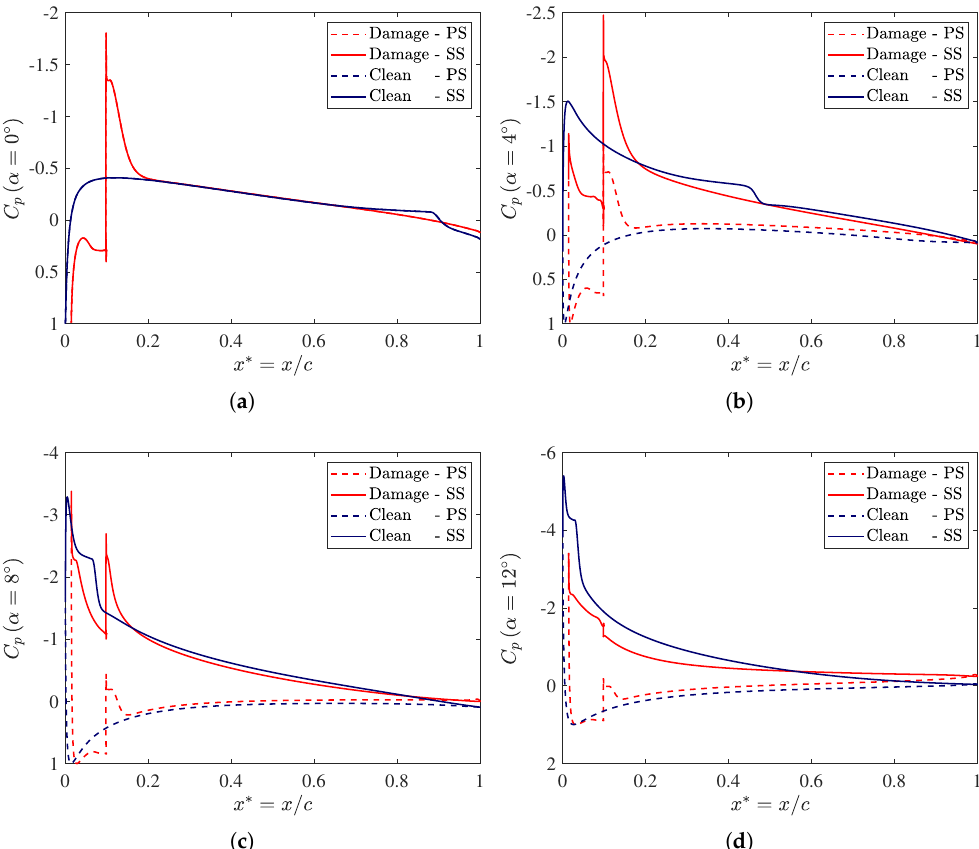
Figure 14. Pressure coefficients comparison between the clean airfoil and the damaged airfoil: the distribution on the Pressure Side (PS) is denoted with the dashed line, while the continuous line is used for the Suction Side (SS) trends. ( a ) C p distribution at 0 ◦ incidence; ( b ) C p distribution at 4 ◦ incidence; ( c ) C p distribution at 8 ◦ incidence; ( d ) C p distribution at 12 ◦